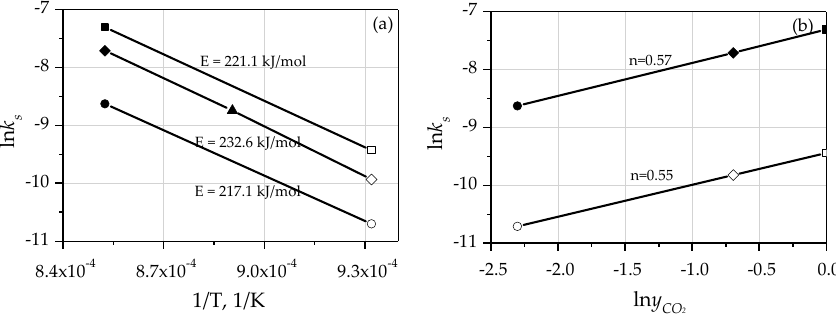
Figure 7. ( a ) Arrhenius plot and ( b ) auxiliary graph for determining reaction order for RPM char Figure 7. (a) Arrhenius plot and (b) auxiliary graph for determining reaction order for RPM char gasification (the meaning of the symbols is the same as in Figure gasification (the meaning of the symbols is the same as in Figure 4).